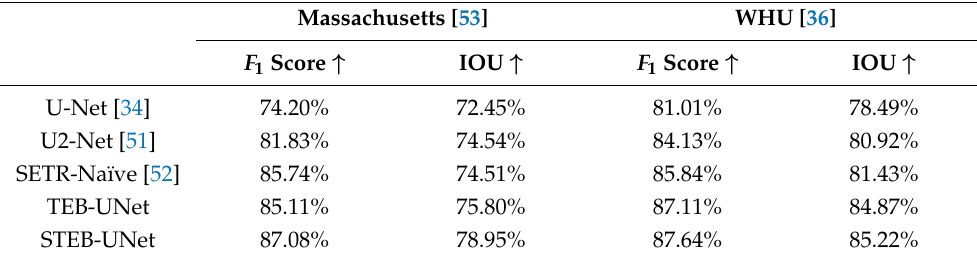
Table 3. The generalization testing of different methods on WHU and Massachusetts